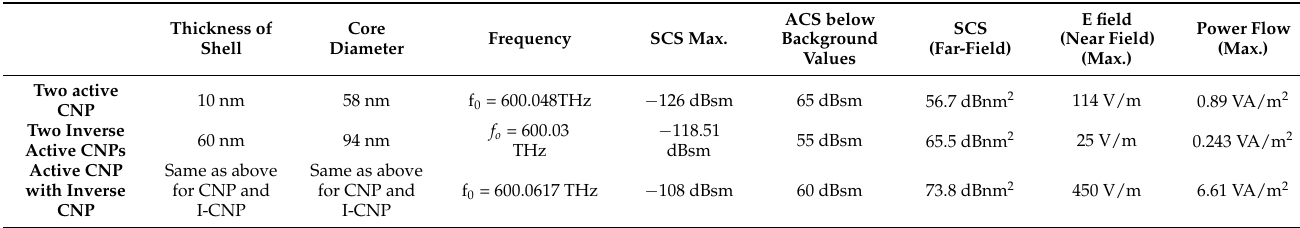
Table 2. The overall benefits of configuration III over configurations I and II.